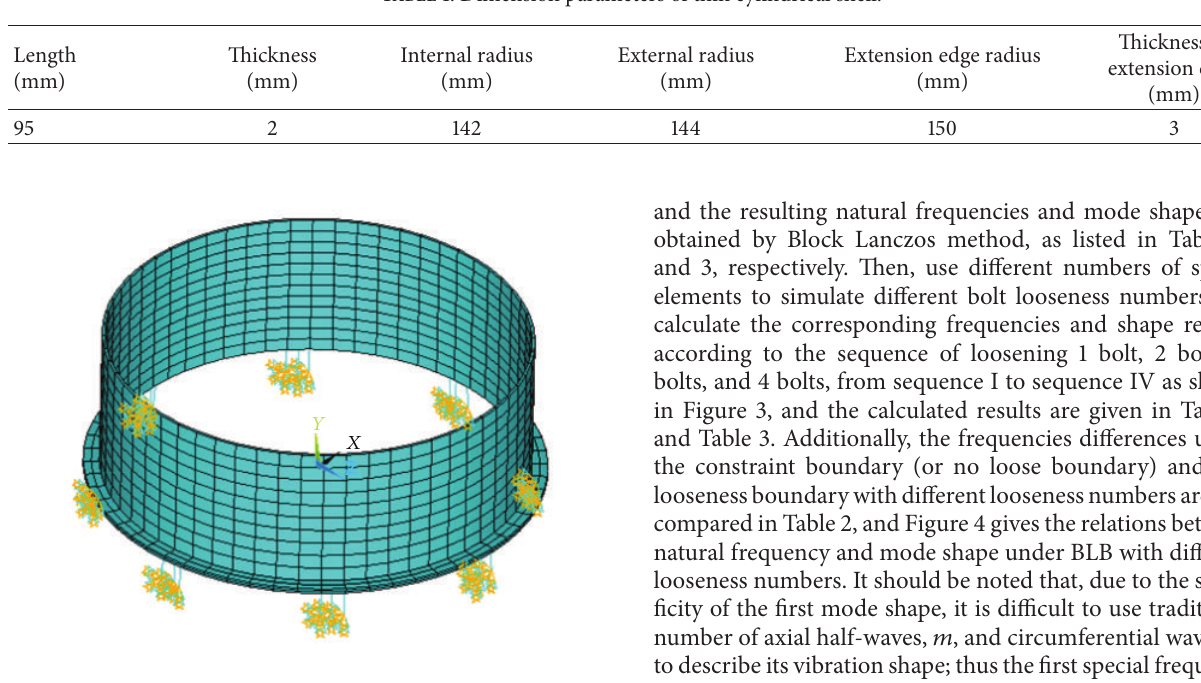
Figure 2: Finite element model of the TCS under BLB with different looseness